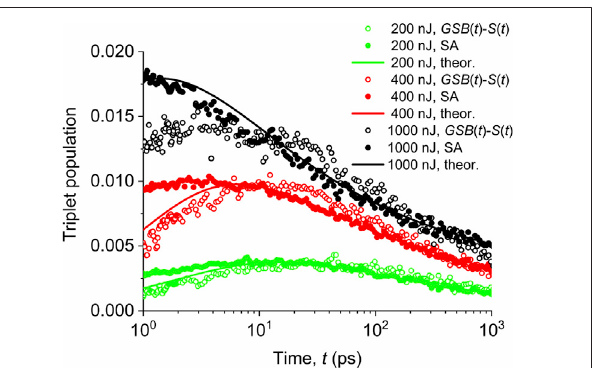
FIGURE 4 | Diffusion coef fi cient of singlet excitons assuming the singlet – singlet annihilation is fully controlled by the singlet exciton diffusion. Shown for different pump fl uences and corresponding initial excitation populations marked in the legend.